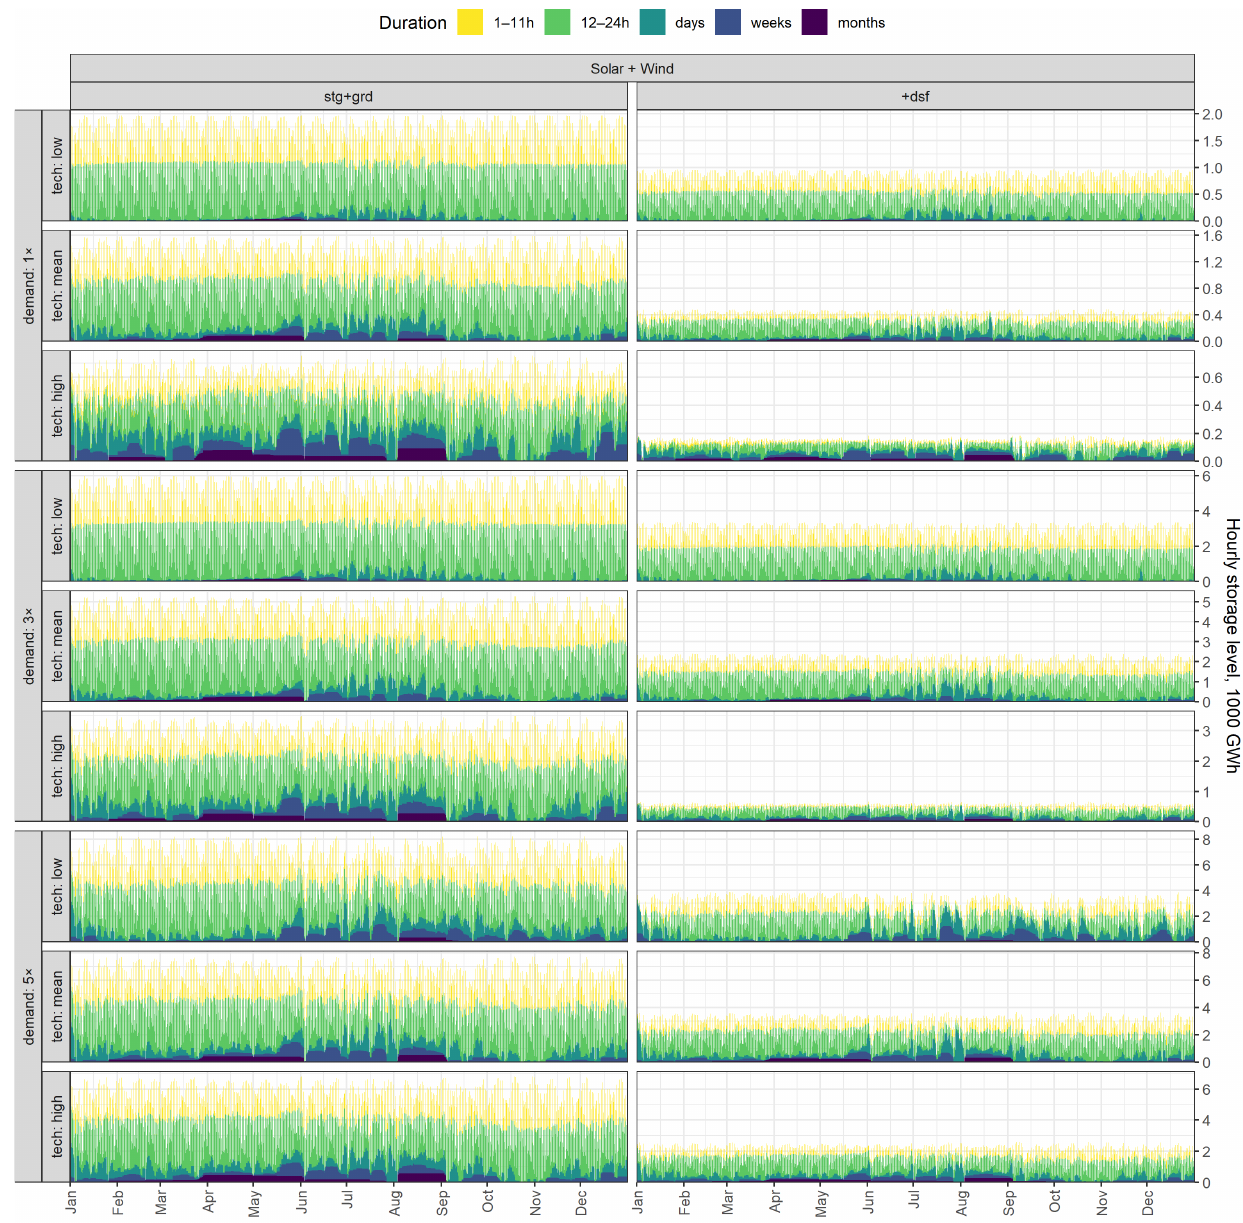
Figure A24. Annual storage operation decomposition by duration of stored energy, nationwide aggregation, scenarios with and without demand-side